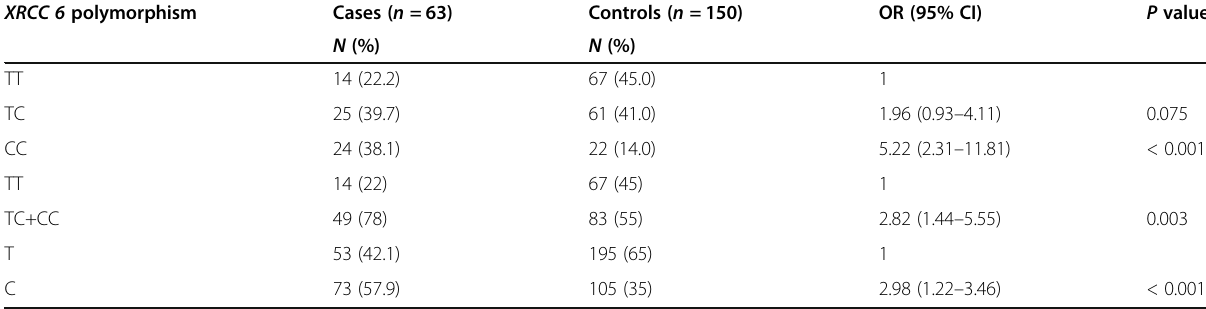
Table 1 Association between polymorphism of XRCC6 T-991C and risk of varicocele XRCC 6